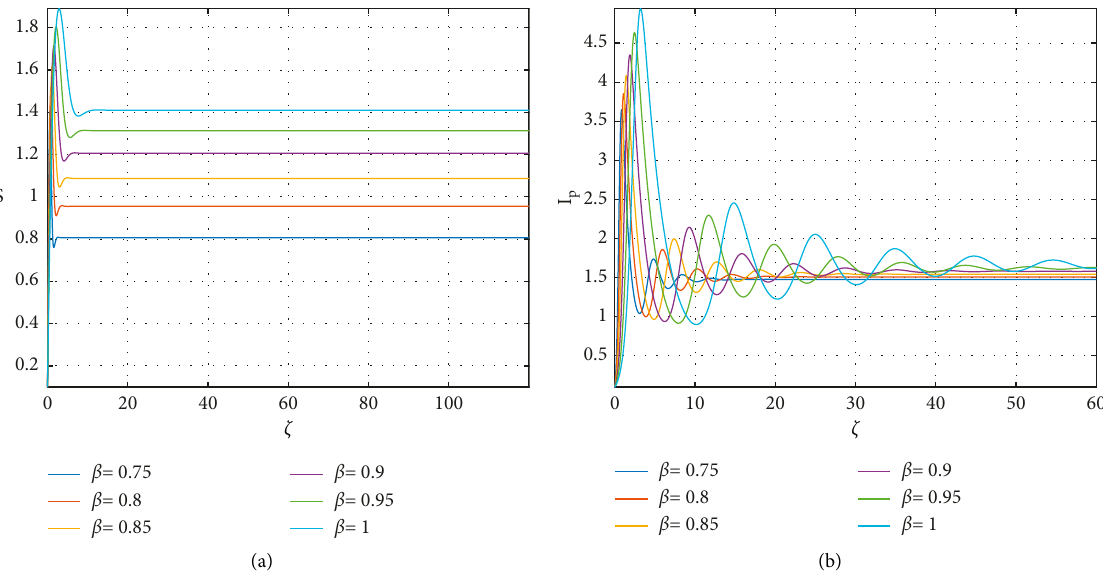
Figure 12: Two-dimensional illustration of the susceptible class S and pneumonia infectious I rate co-infection ρ for multiple fractional orders β ∈ [ 0 , 1 ] .